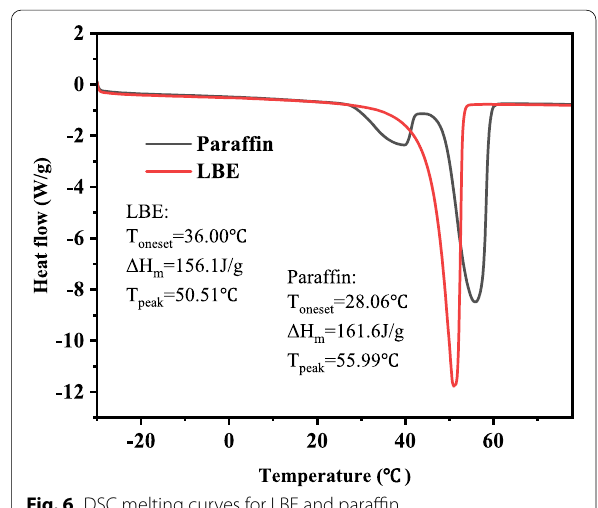
Fig. 6 DSC melting curves for LBE and paraffin